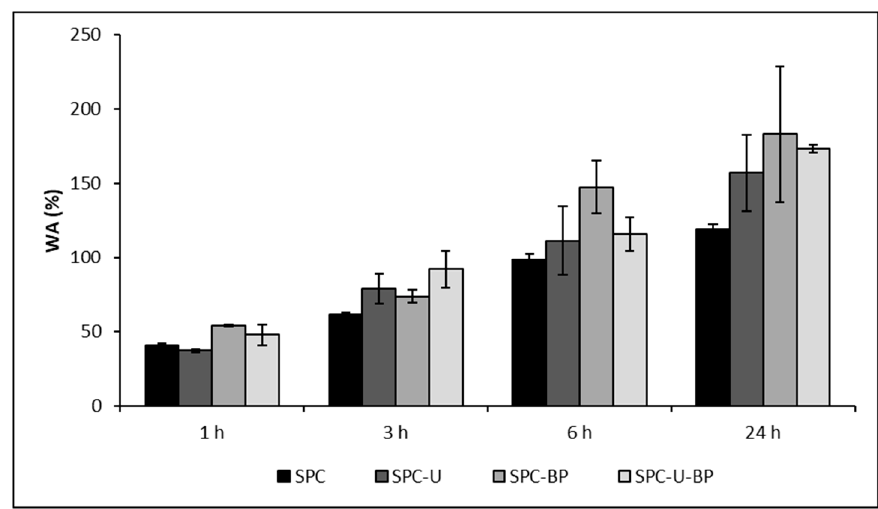
Figure 5. Thickness swelling (TS) of the injection-molded pieces after immersion in water.